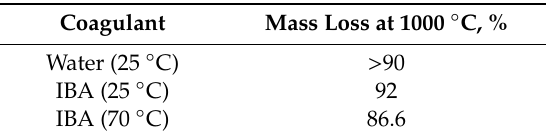
Table 3. The carbon yield of the fibers formed into various precipitation baths, followed by washing with water, when heated to 1000 ◦ C.